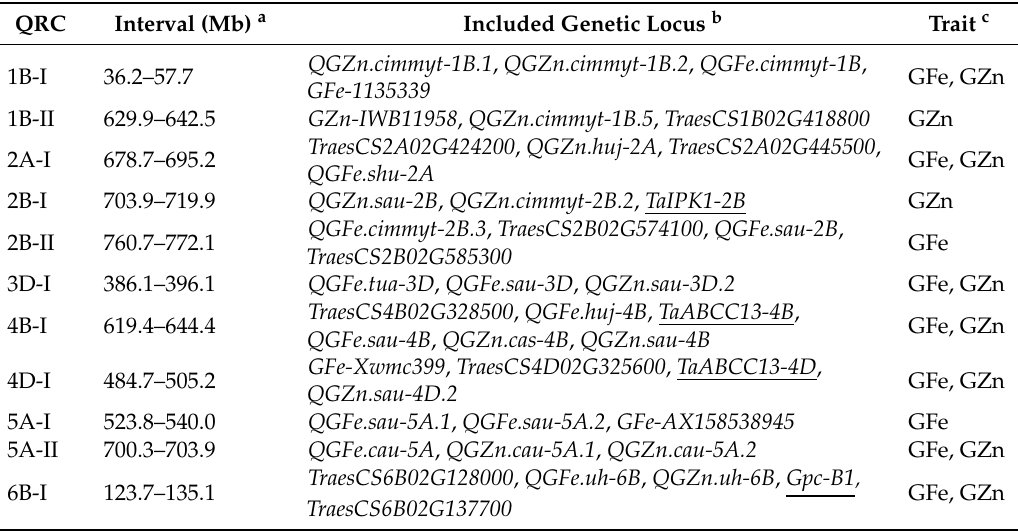
Table 1. QTL-rich clusters (QRCs) for wheat Fe and Zn